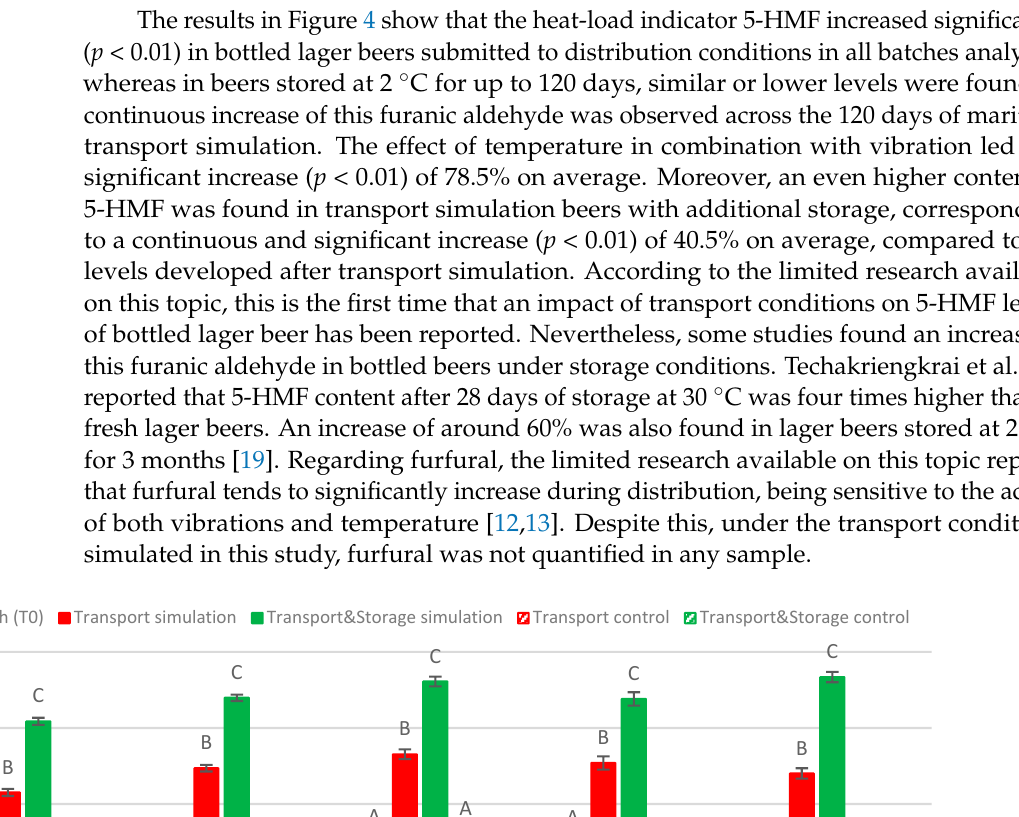
Figure 5. Evolution of acetaldehyde under the simulated conditions. A Tukey test was performed for each batch. Different letters represent statistically significant differences ( p < 0.05). 2.3. Beer Color In general, the results show differences between fresh beers and transport simulation beers (Figure 6). The maritime transport conditions simulated (45 days of travel at 21–30 °C and 1.7 Hz) led to a slight, but significant, increase in beer color of 0.6 EBC units on average ( p < 0.01), whereas in transported beer samples with additional storage for 75 days between 19–29 °C, no variation in color was observed when compared to their